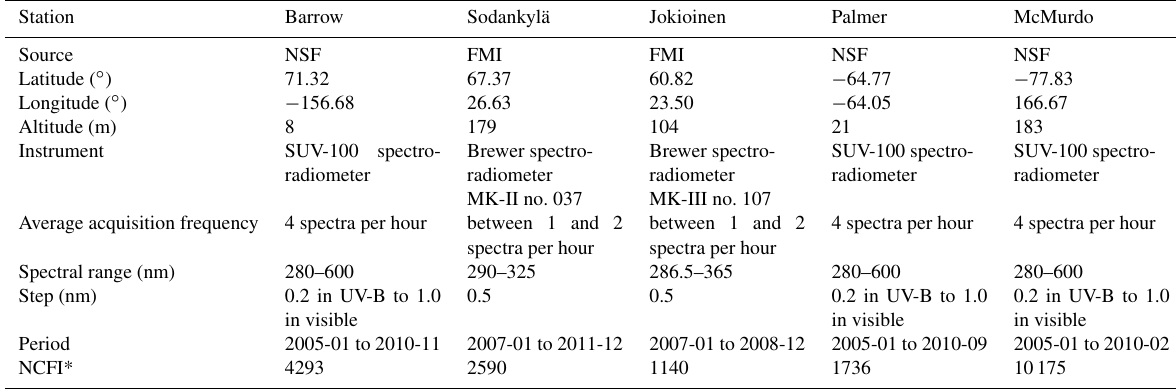
Table 1. Description of stations used for validation, ordered by decreasing